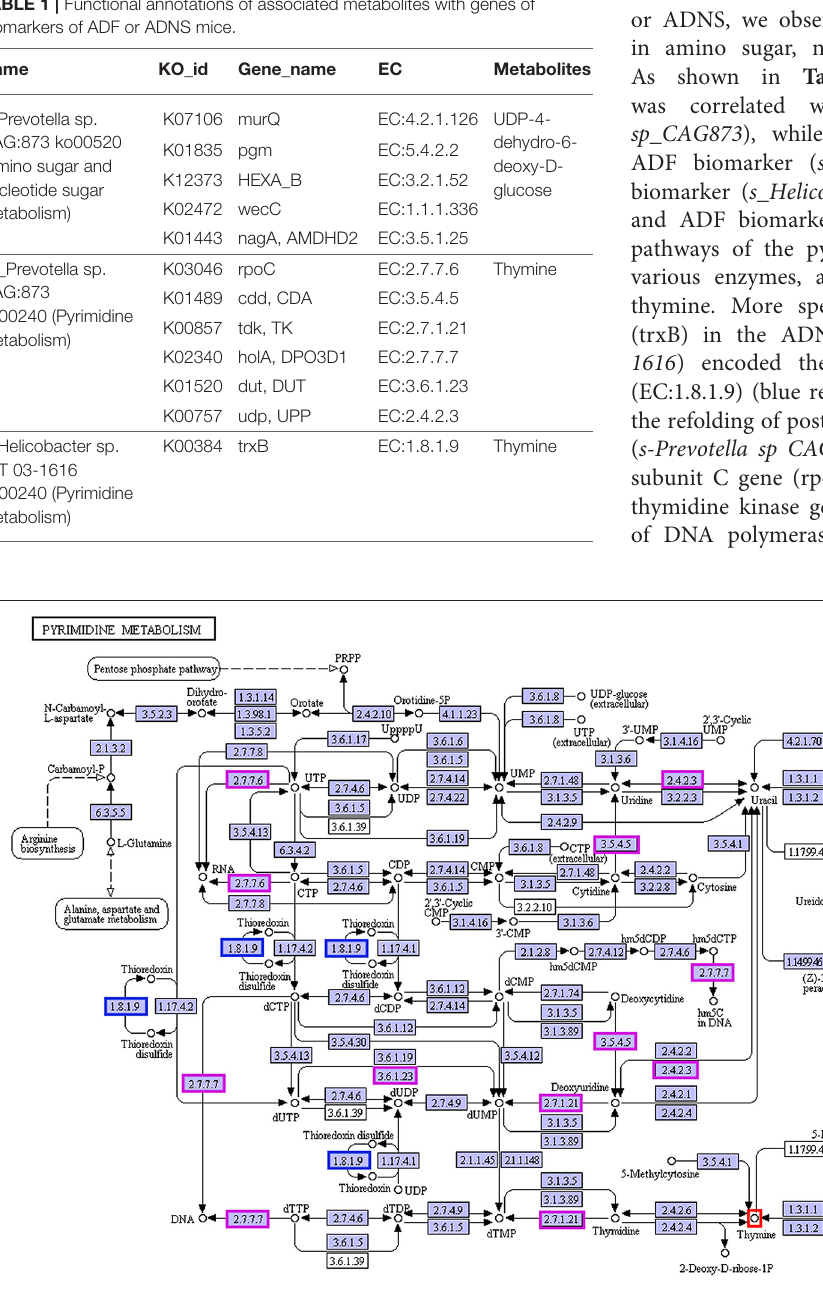
ADNS to the WT levels [ Figure 7B , Supplementary Table 7 : the correlation analysis of the species and 20 differential metabolites (p value)].